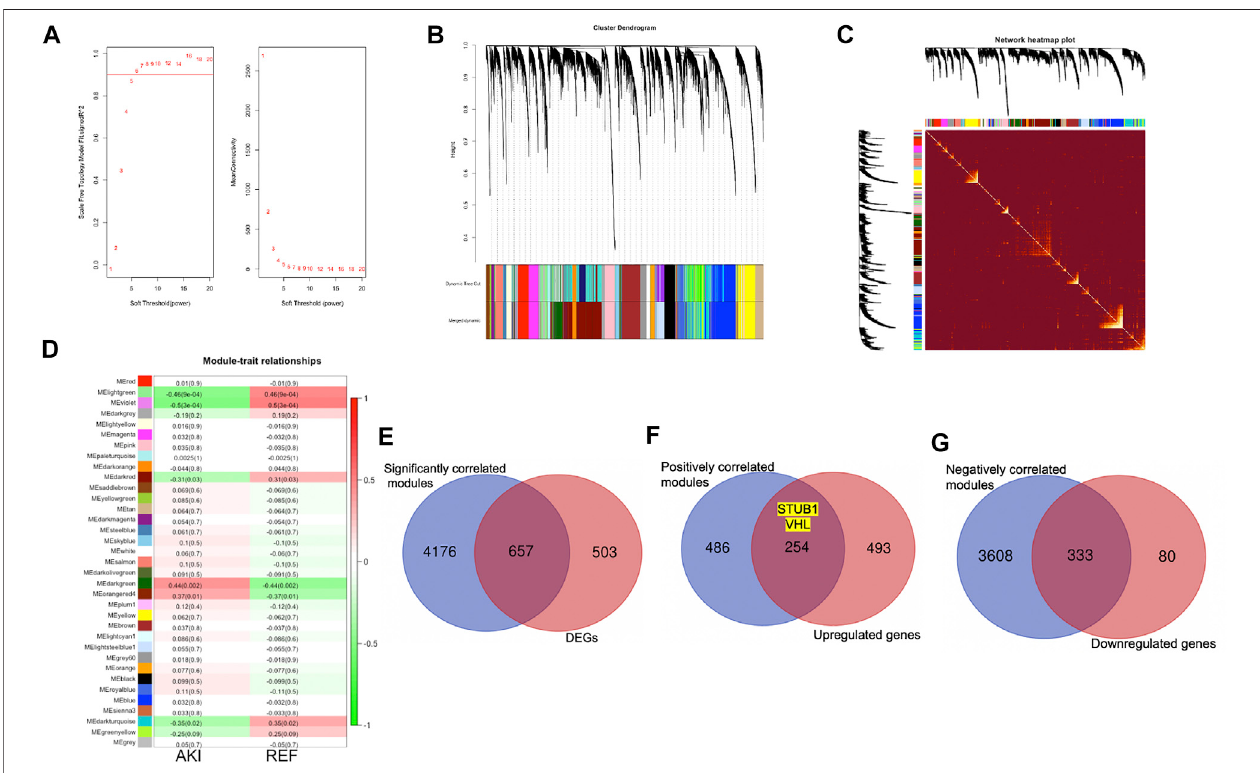
FIGURE5| Co-expression networkconstructionbyWGCNA. (A) Analysisofoptimal soft-thresholdingpower. Analysisofdifferentpowers onscaleindependence (left) and mean connectivity (right) . (B) Clusterdendrogramof16,128 protein coding genesand 35 modules forAKI and normalsamplenetworks. (C) Heat-map ofthe interactions among co-expression modules. The intensity of yellow represents the interconnectedness among different modules. (D) Heatmap of the correlation betweentheMEsandclinicaltraitswithAKIorREF. (E) Overlapofgenesidenti fi edinbothDEGsandsigni fi cantlycorrelatedmoduleswithAKI. (F) Overlapofgenes identi fi ed in both upregulated genes and positively correlated modules with AKI. (G) Overlap of genes identi fi ed in both downregulated genes and negatively correlated modules with